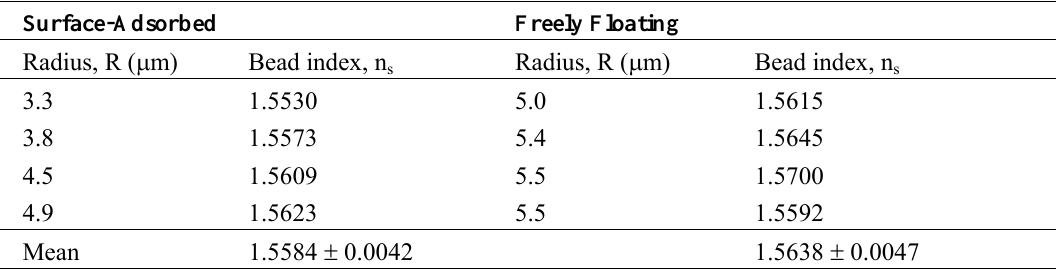
Table 1. Calculated bead indices, n freely floating